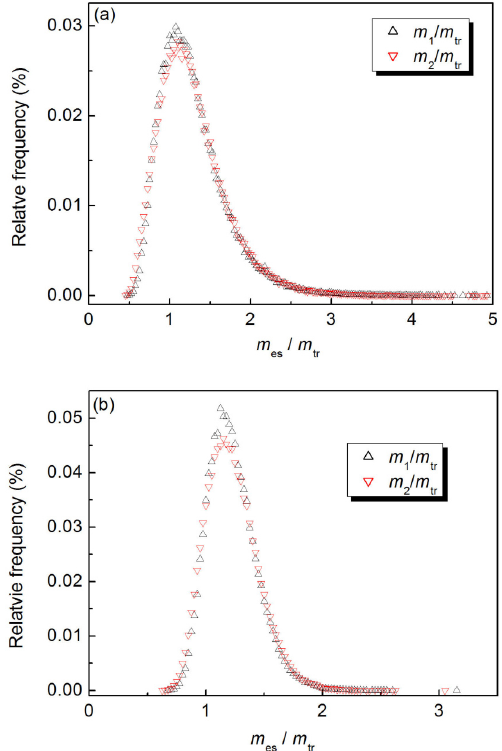
Fig. 7 Empirical probability density functions of / m m estimated with the simple method and the LS es tr method: (a) N = 10; (b) N = 30.